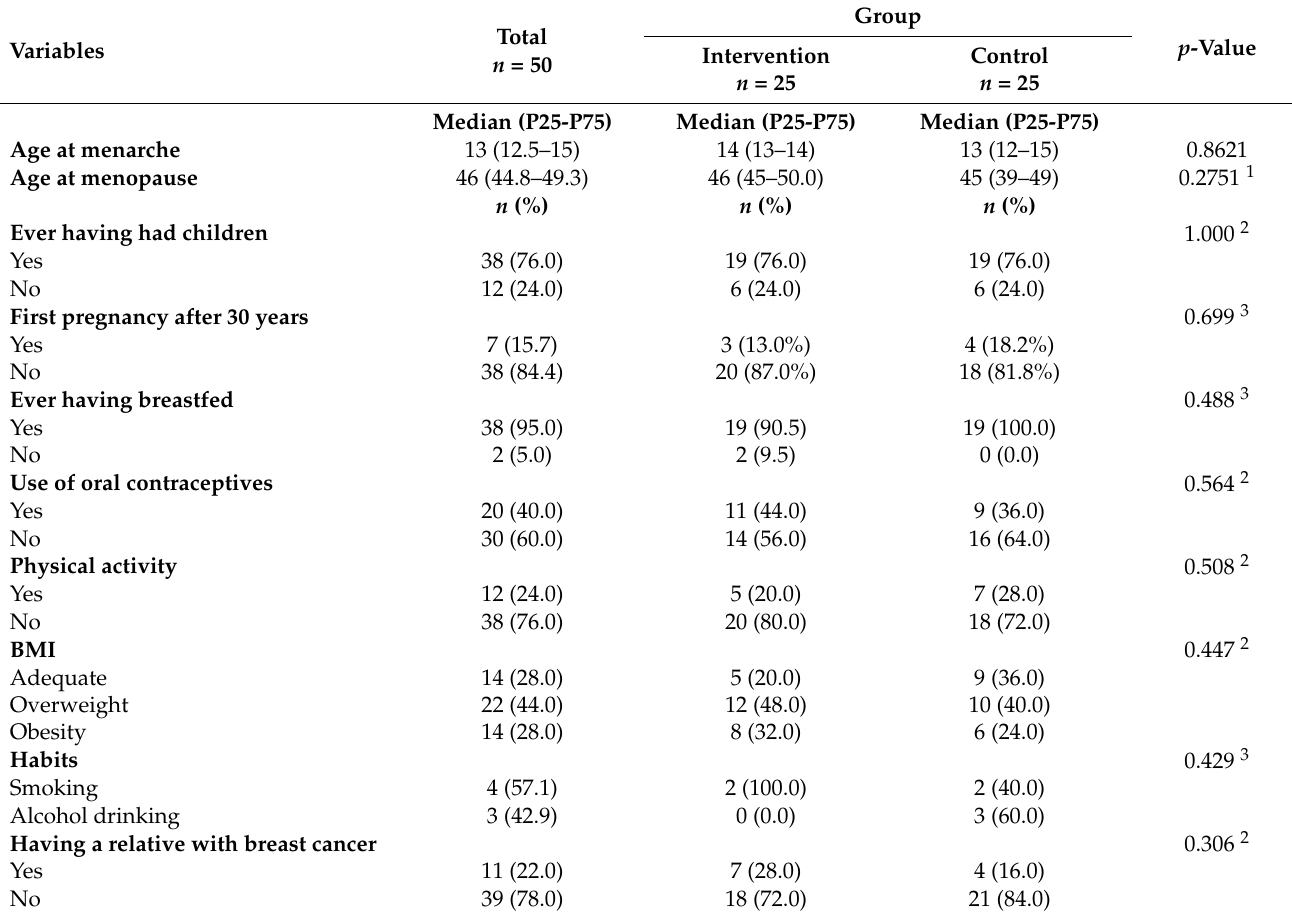
Table 2. Predictive factors for breast cancer in the participants.